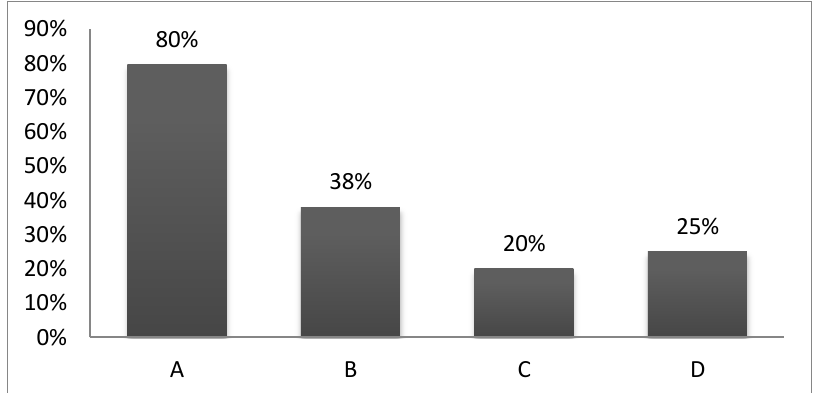
Figure 4.3 :Students preferred Islamic